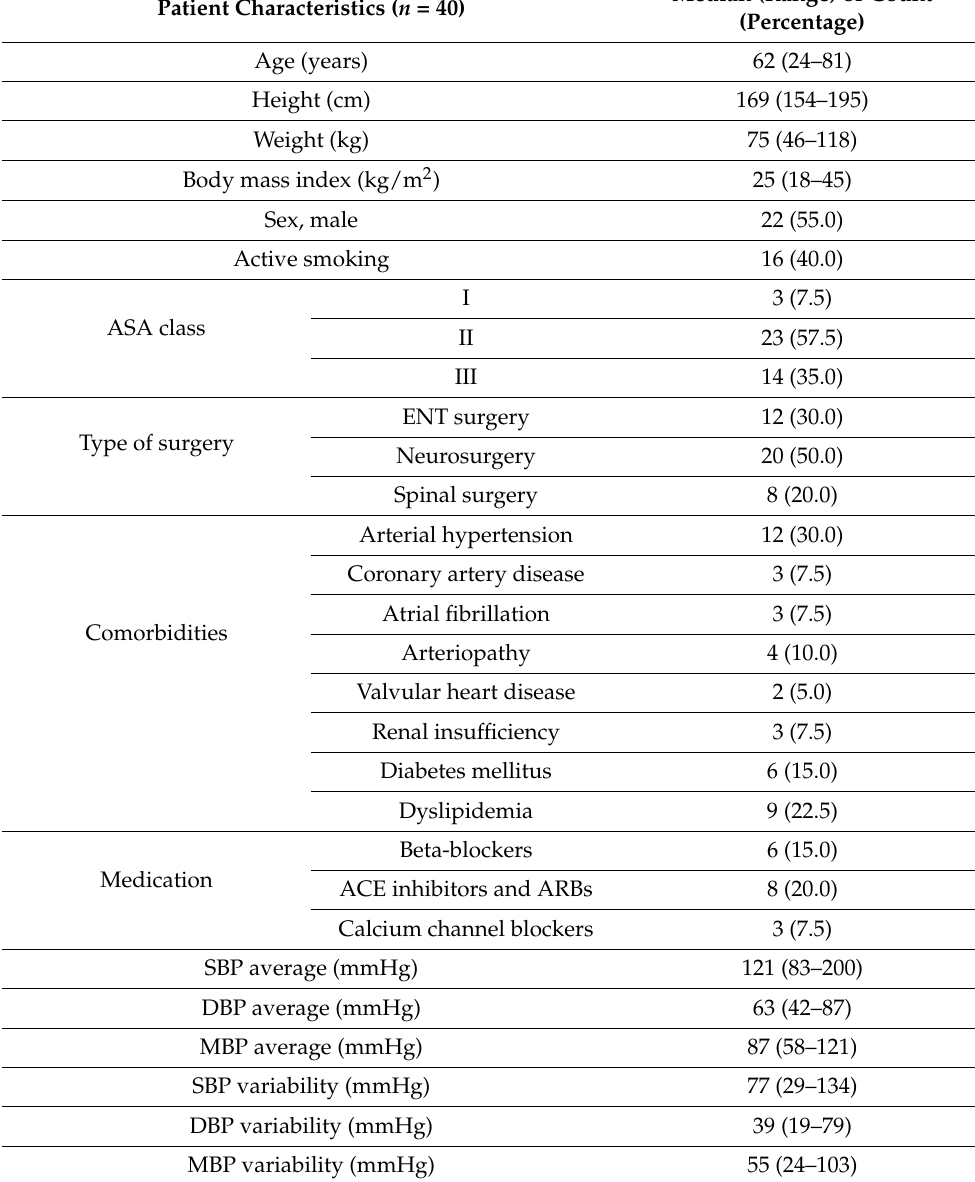
Table 1. Demographic and biometric characteristics of the 40 patients. The data are given as median (range) or count (percentage) over the cohort. The average blood pressure (BP) and variability values are the per-patient average value and per-patient minimal–maximal range of invasive BP throughout the entire recording. ENT: ear nose throat, ASA: American Society of Anesthesiologists, ACE: angiotensin-converting enzyme, ARB: ngiotensin II receptor blockers, SBP, DBP, and MBP: systolic, diastolic, and mean BP,